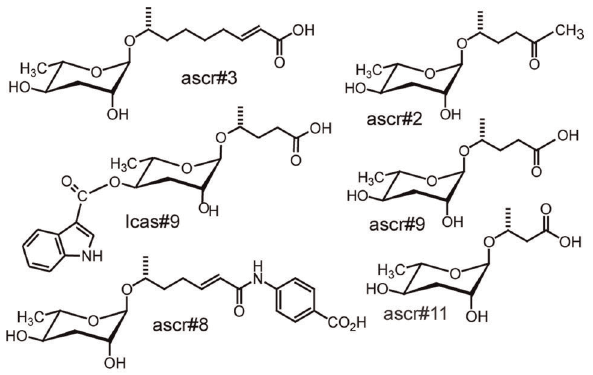
Figure 2. Structures of ascarosides. Structures of published